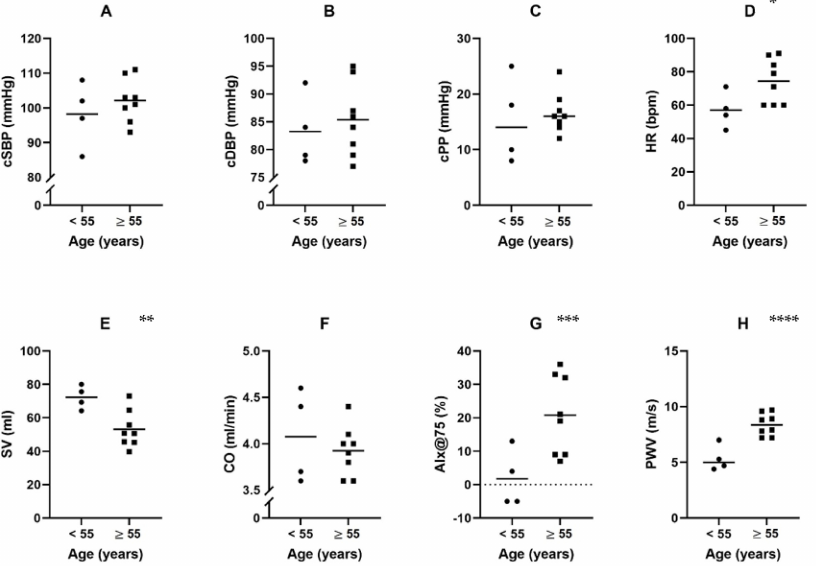
Figure 2. Distribution of non-invasive hemodynamics in HF with an LVAD within different